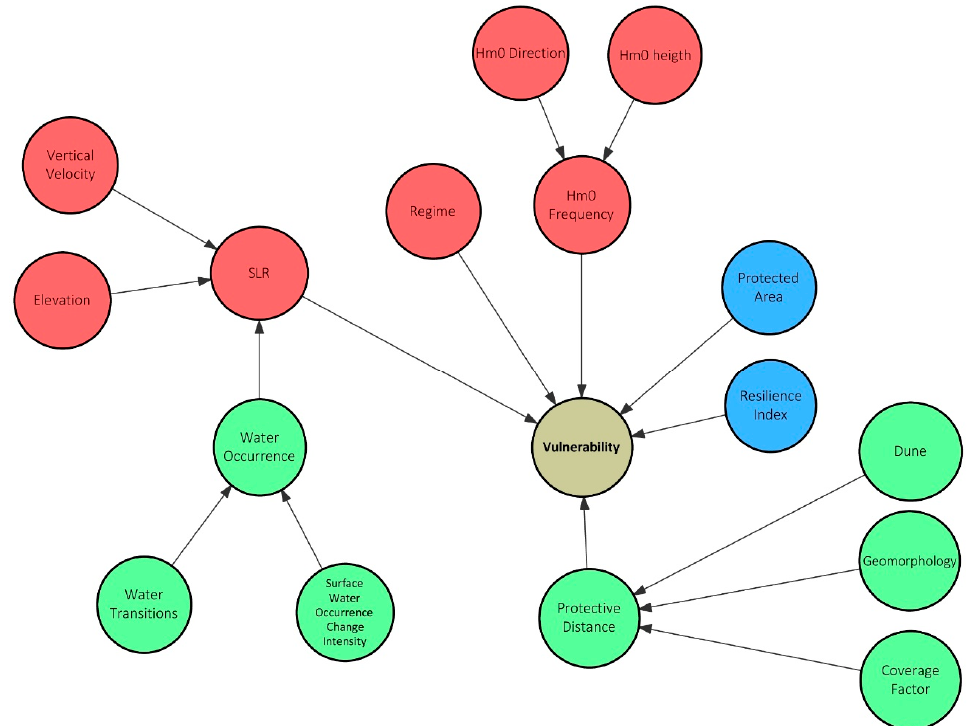
Figure 6. BBNs developed to model vulnerability in the Po River Delta. The nodes are grouped and colored based on the types of variables representing the sources, driver factor (red), the pathway, land cover factor (green), the receptors, land use factor (blue), and the consequence target node (beige). Arrows denote the direction of probabilistic influence implemented in software rather than causal relationships between the variables.